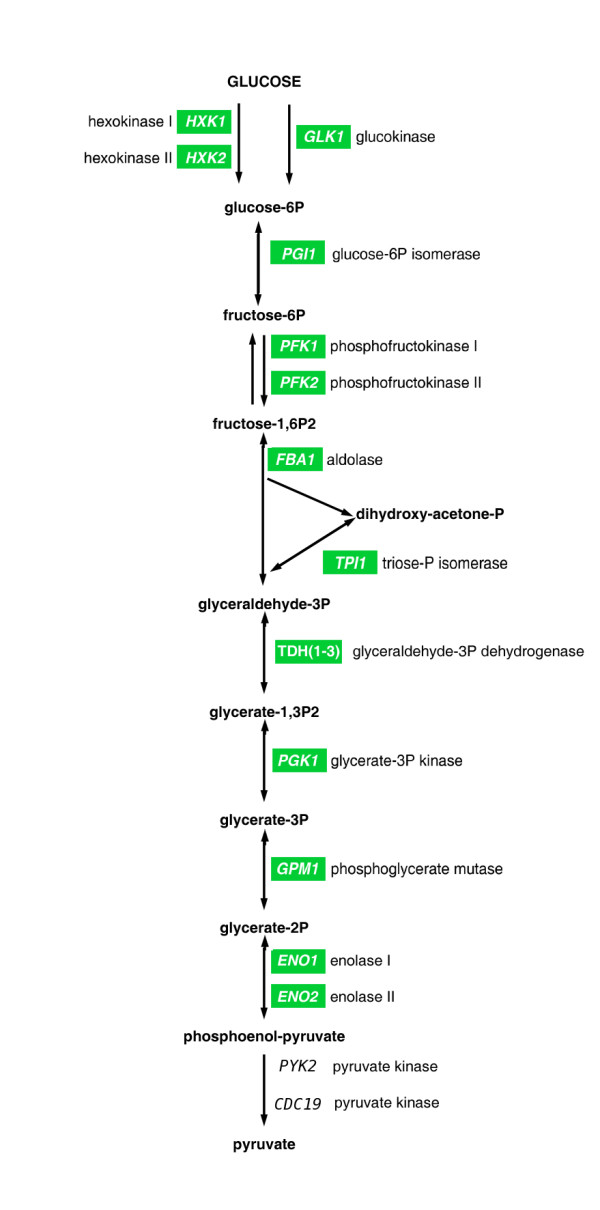
Scheme of the glycolytic pathway. Genes codifying for the enzymes implicated in each step are detailed; green labels indicate genes whose expression was reduced upon daunorubicin treatment.